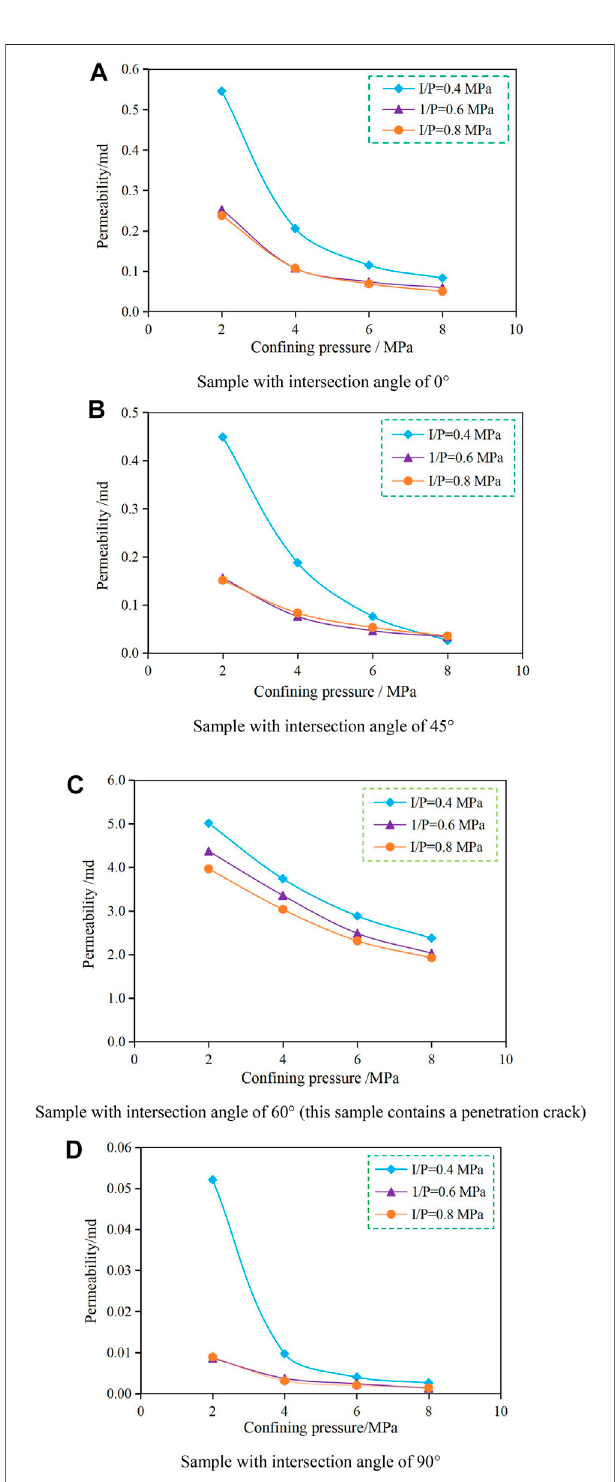
FIGURE 9 | Permeability evolution of WJZ coal samples under different con fi ning pressures and inlet gas pressures. (A) Sample with intersection angle of 0 ° (B) Sample with intersection angle of 45 ° (C) Sample with intersection angle of 60 ° (this sample contains a penetration crack) (D) Sample with intersection angle of 90 °